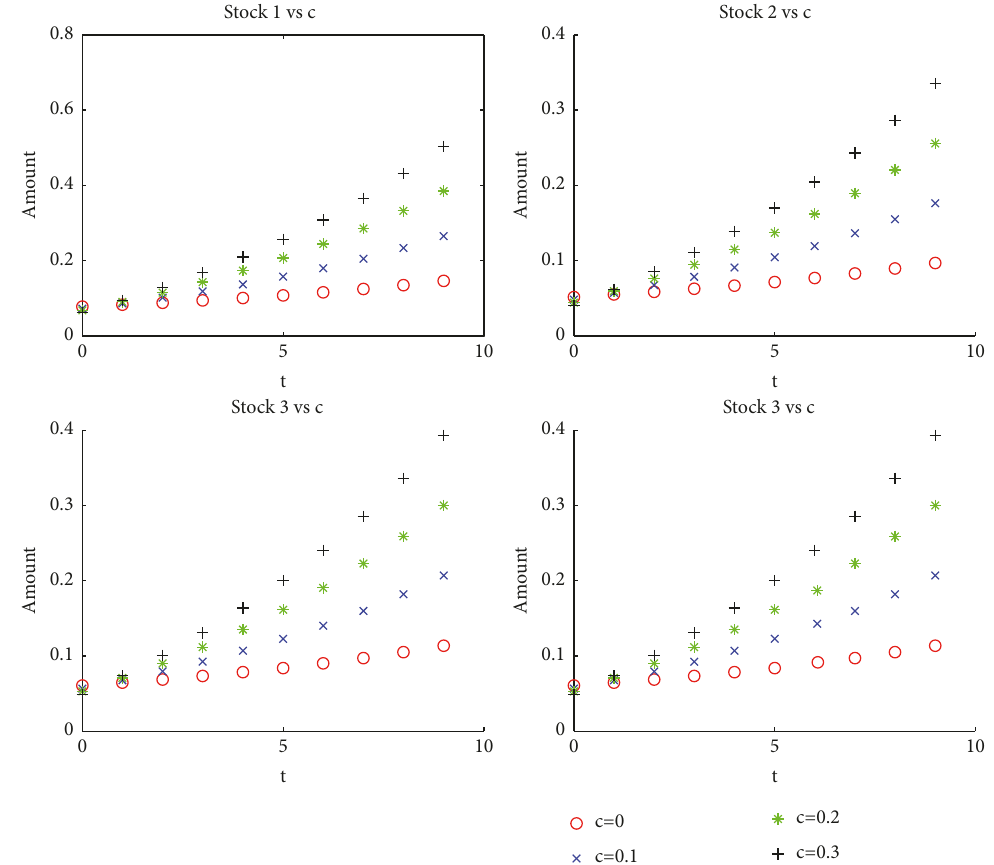
Figure 4: Equilibrium strategy under different contribution